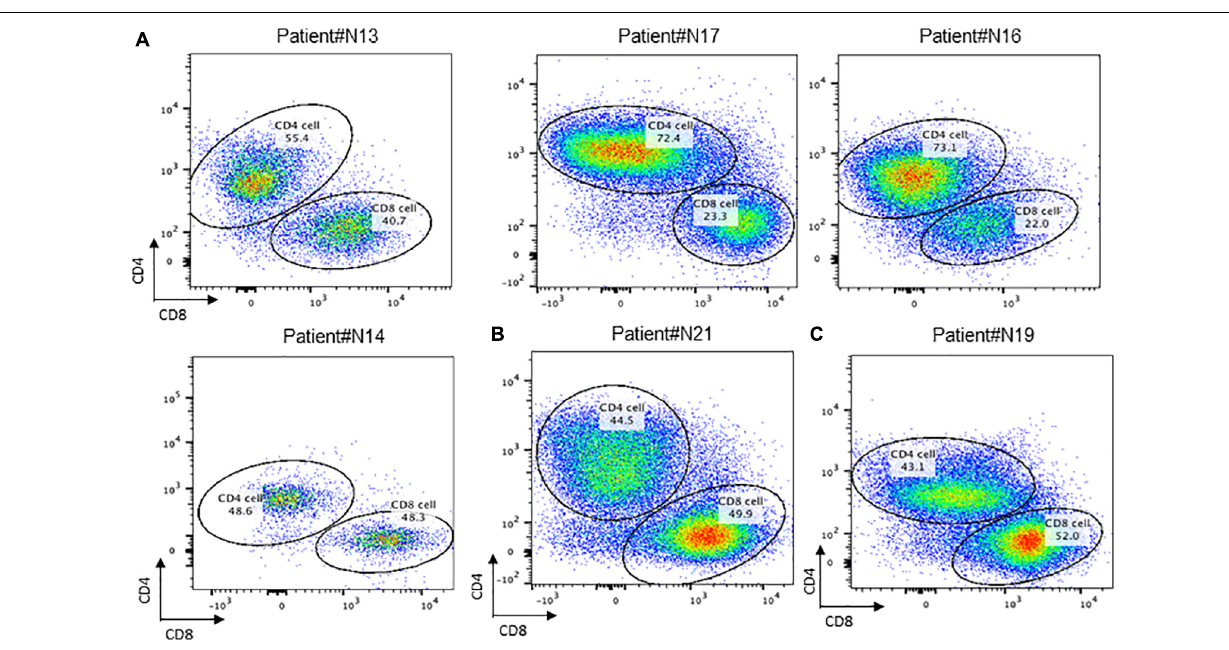
data (GSE134797). Five differently expressed circRNAs with high expression in nasopharyngeal carcinoma tissues were obtained by differential analysis of RNAseq data ( Figure 5A ).